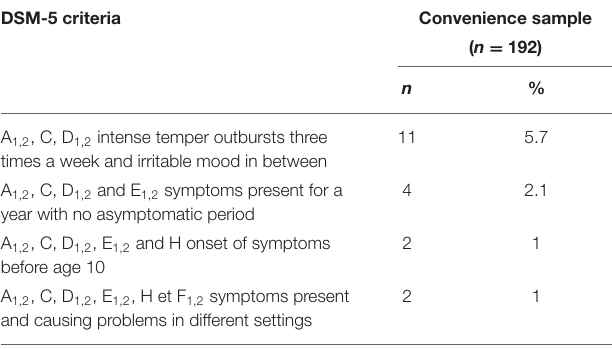
TABLE 2 | Frequency of DMDD questionnaire items based on DSM-5 criteria. DSM-5